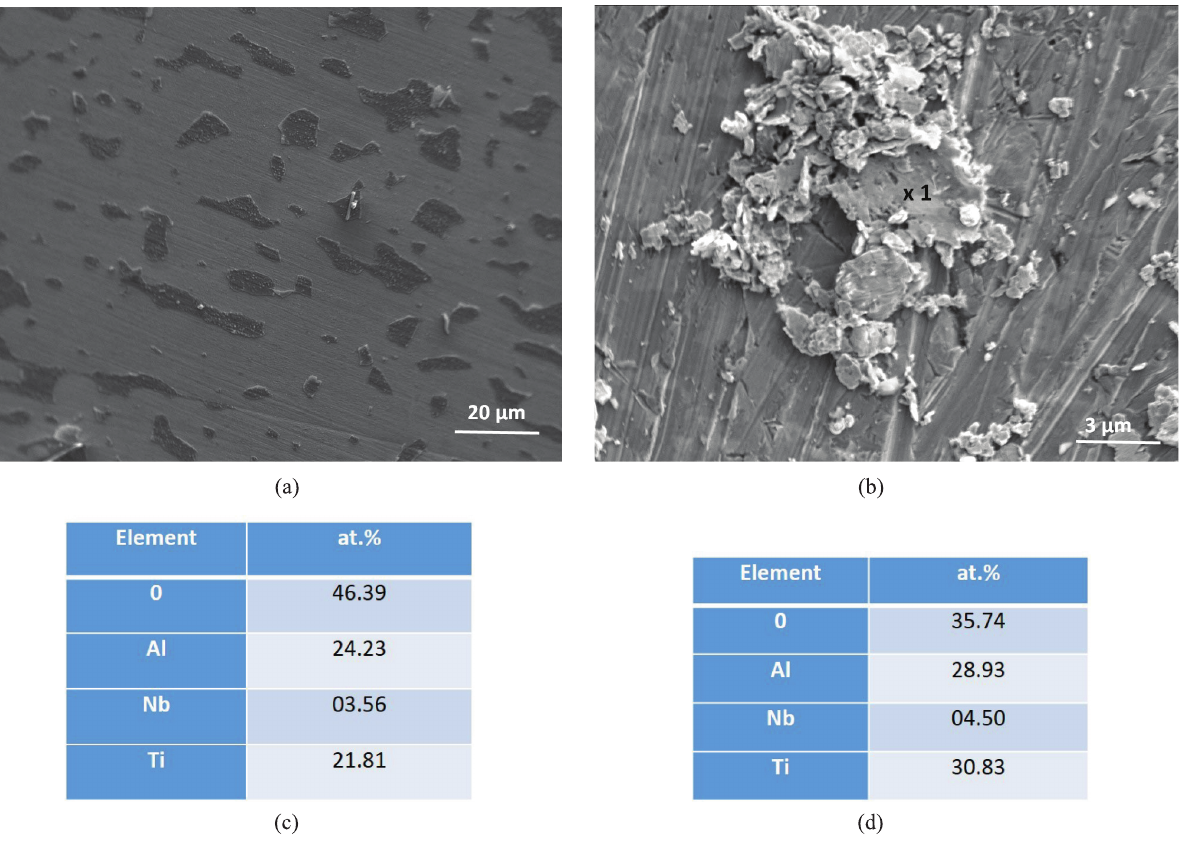
Fig. 7: (a–b) The surface Ti-46Al-7Nb-0.7Cr-0.1Si-0.1Ni with Al 2 O 3 layer applied after the isothermal oxidation